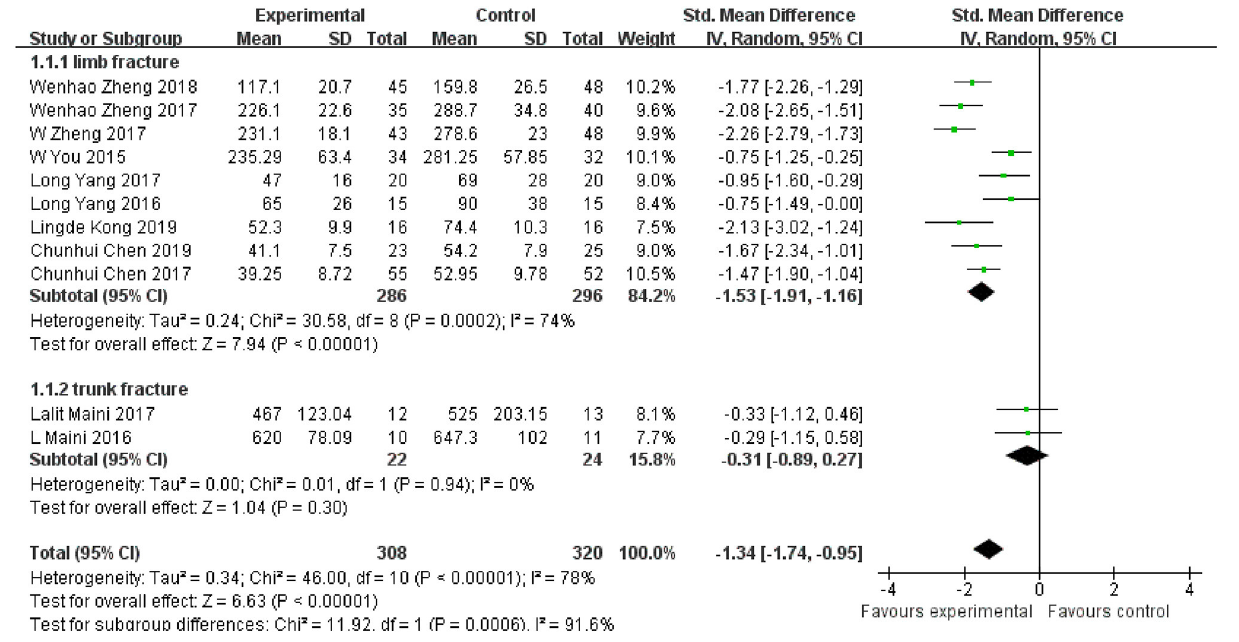
FIGURE 5 | Meta-analysis results of intraoperative blood loss.